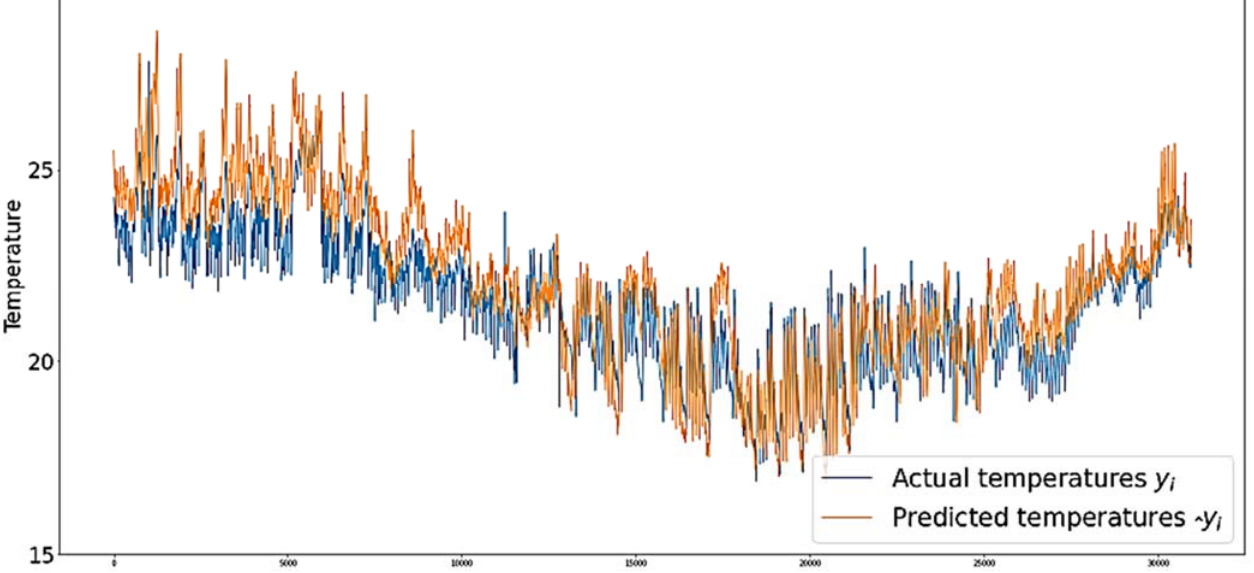
Figure 19. Plot of actual and predicted temperatures 5 h ahead for office 40 on the first floor.